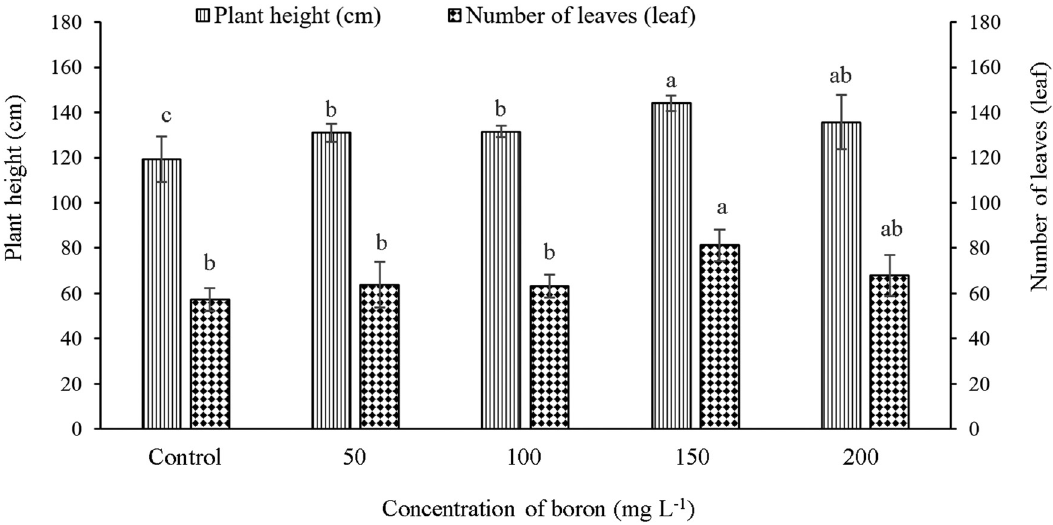
Figure 1: Plant height and number of sesame leaves at harvest for di ff erent concentrations of boron. Letters within the columns represent a signi fi cant di ff erence ( P < 0.05 )